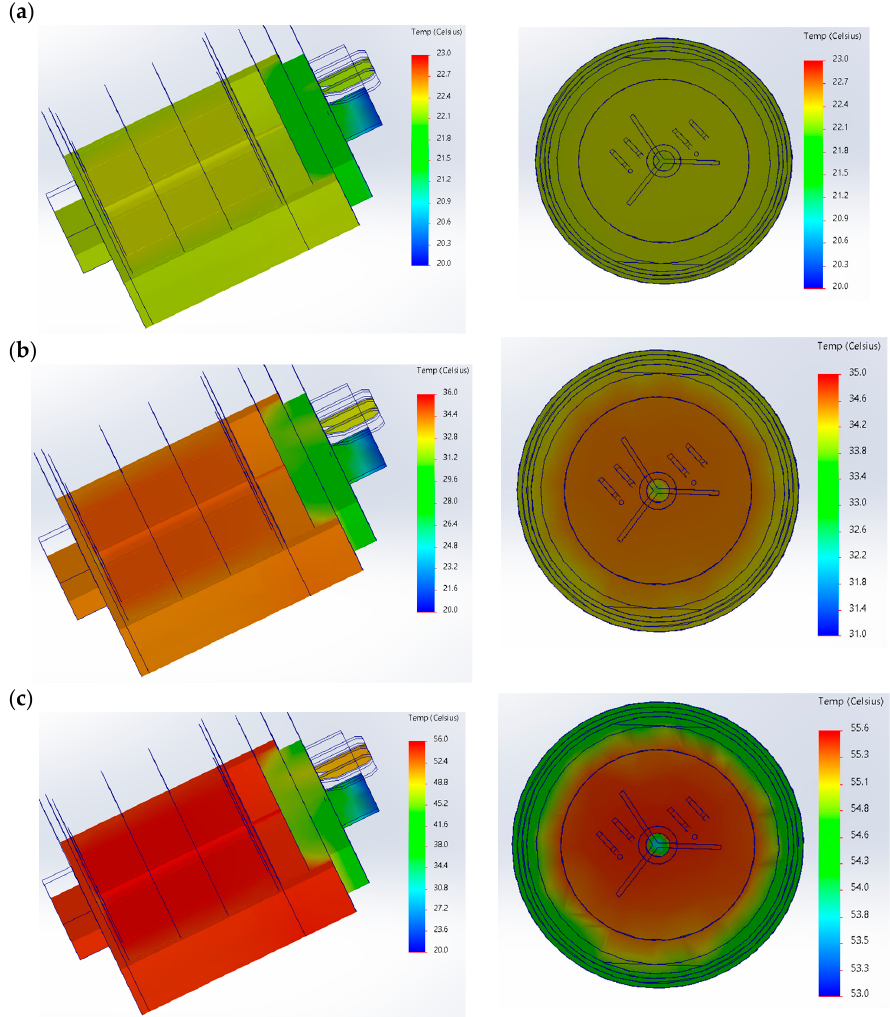
Figure 11. Temperature distributions obtained inside the capacitor when the temperature of the capacitor case is ( a ) 22.0 °C, ( b ) 34.0 °C, and ( c ) 54.0 °C.